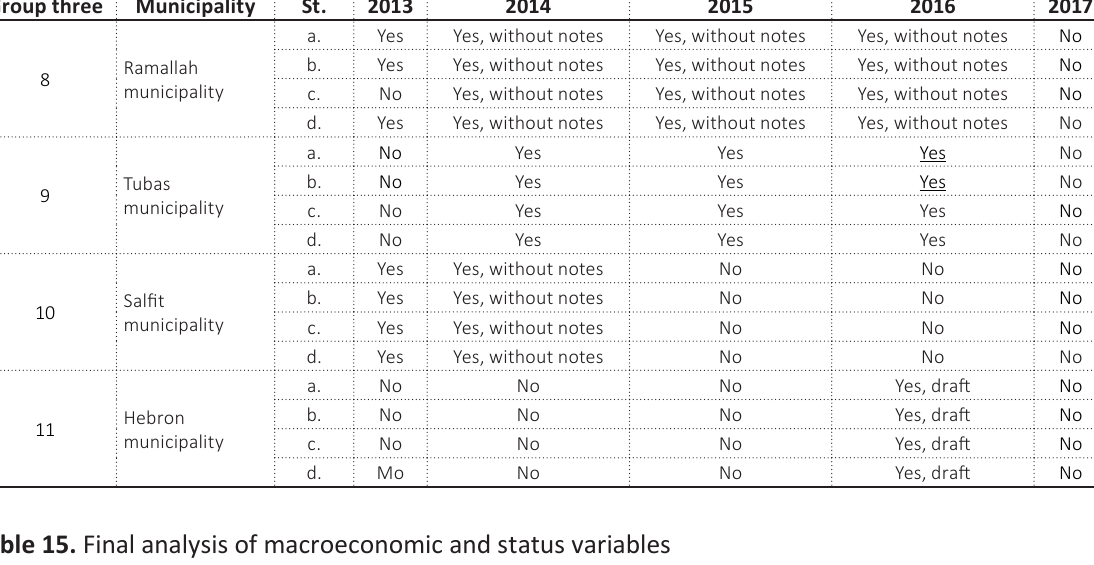
Table 14. Municipality’s financial statements according to the accrual basis by IPSAS Group three